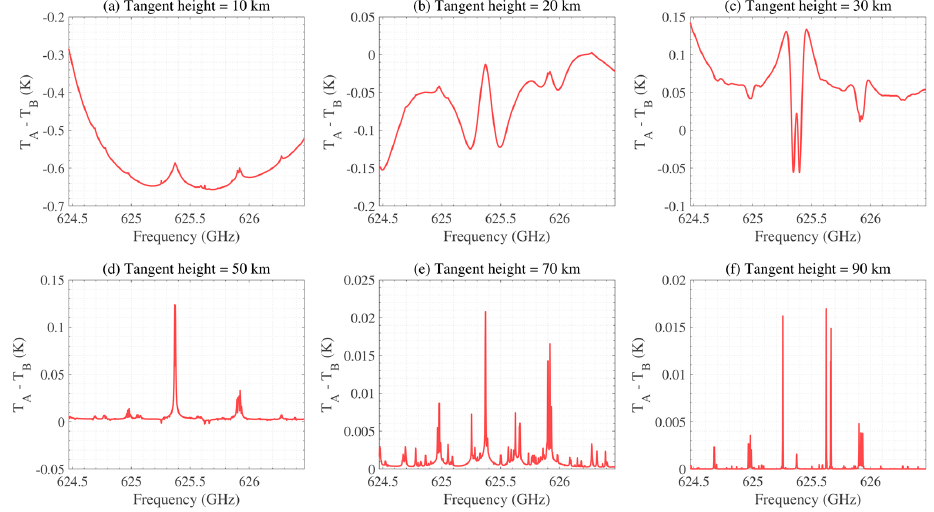
Figure 18. The brightness temperature difference 𝑇 (cid:3002) – 𝑇 (cid:3003) at various tangent height measured by 643 GHz radiometer (625 GHz spectrometer): ( a ) 10 km; ( b ) 20 km; ( c ) 30 km; ( d ) 50 km; ( e ) 70 km; ( f ) 90 km.